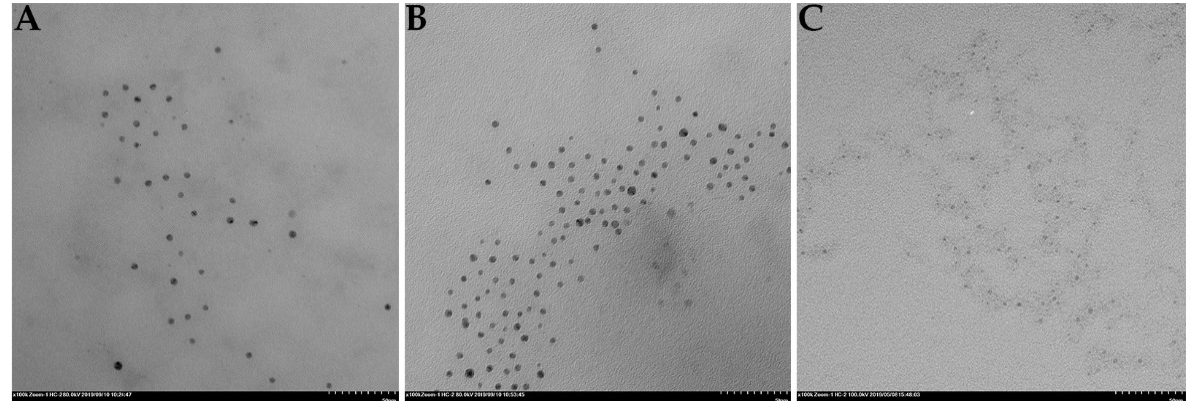
Figure 2 . TEM images of ( A ) AS1411-gold nanoparticles, ( B ) AS1411-gold nanoparticles with IQ, and ( C ) AS1411-gold nanoparticles with C 8 .